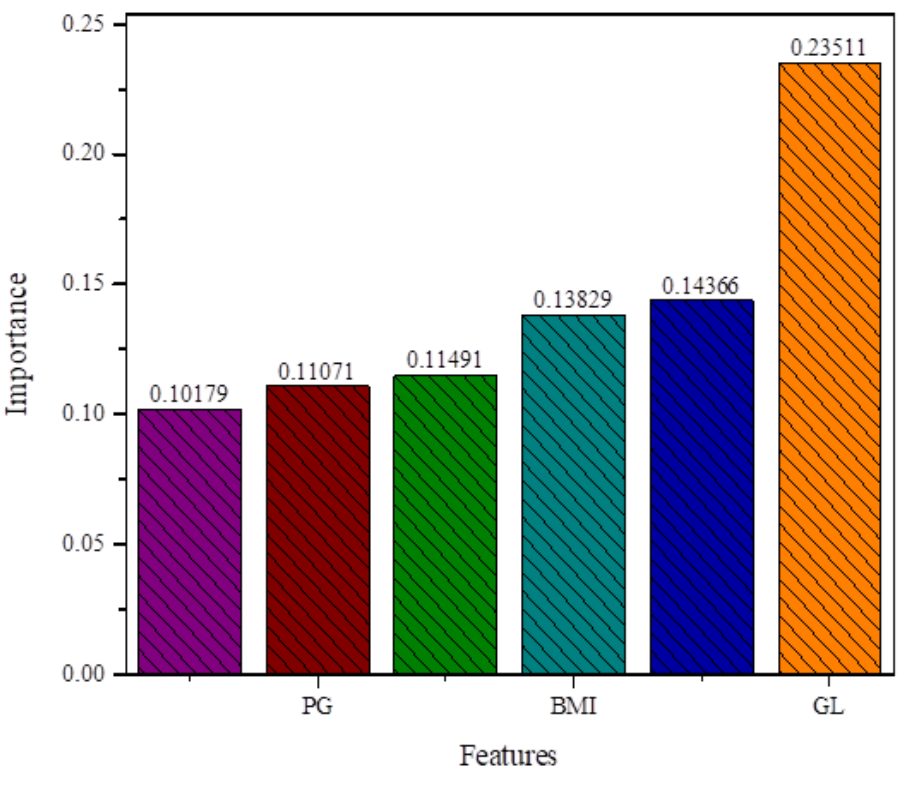
Figure 5. Feature selected by DT (ID3)